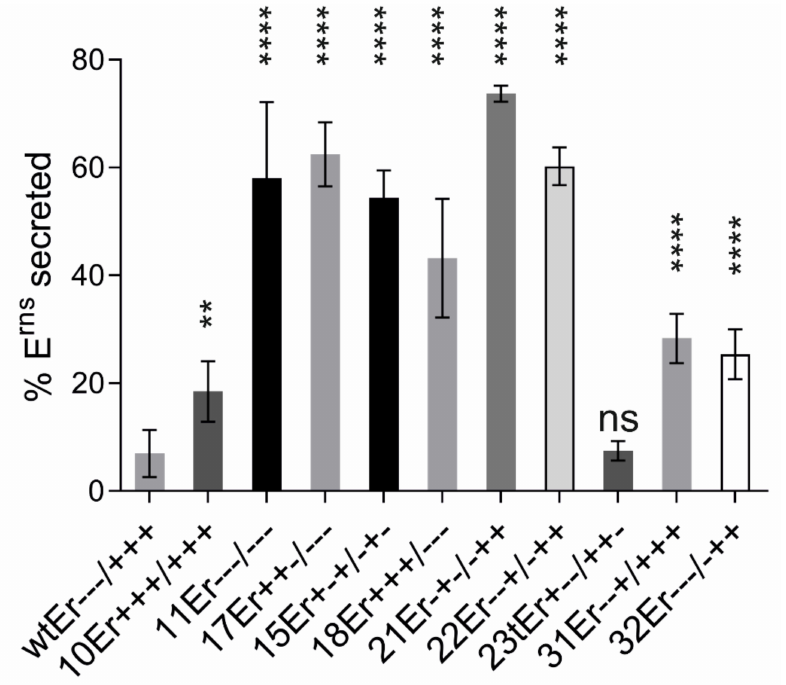
Figure 7. Charge exchange mutations in the membrane anchor can increase E rns secretion. Results of immunoprecipitation experiments from extracts or supernatants of BHK-21 cells transiently expressing E rns (from construct SE rns [19]) or mutants thereof with exchanges affecting the charged residues in the E rns carboxy-terminus. The radioactively labelled proteins were precipitated from the supernatant and cell extract with E rns specific mab 24/16, treated with PNGase F and separated by SDS-PAGE. The diagram summarizes the results of at least three independent experiments quantified via phosphorimager analysis. The number of the individual construct together with the charge distribution in the E rns carboxy-terminus are given at the X-axis. The bars represent the amount of secreted protein as percent of total recovered E rns . For calculation, the counts determined for extra- and intracellular E rns were set to 100% expression product as basis for calculation of the secretion value. Error bars are indicated as well as the p -Value of E rns mutants compared to E rns wt with **** representing p < 0.0001, ** p = 0.002 for 10Er and ns = not significant for 23Er. “-“ indicates a negative, “+” a positive